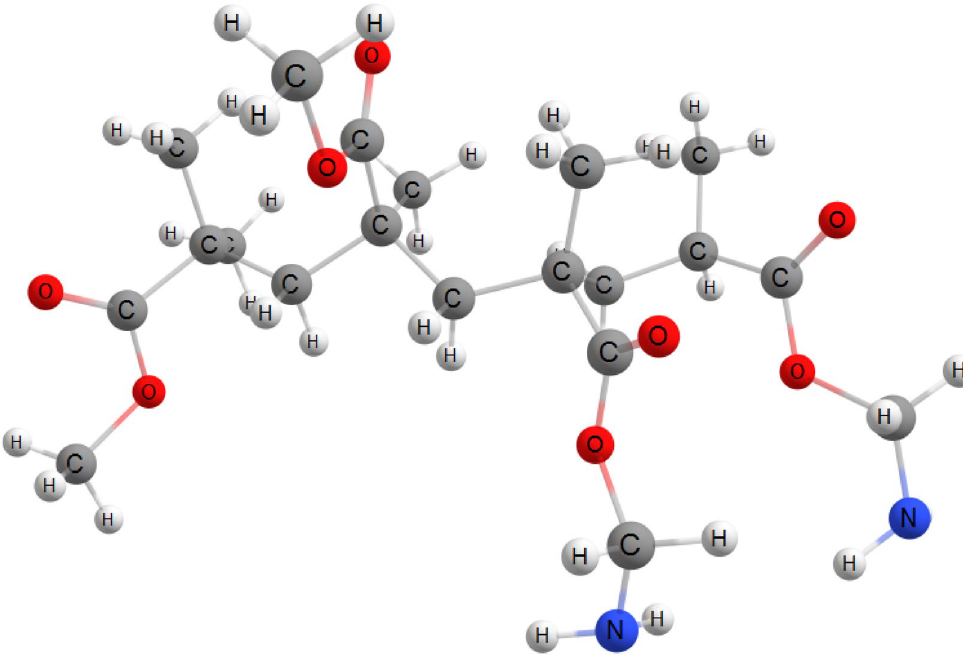
Figure 4. Optimized geometry of the C 20 H 36 N 2 O 8 molecule used as a model of PMmae polymer